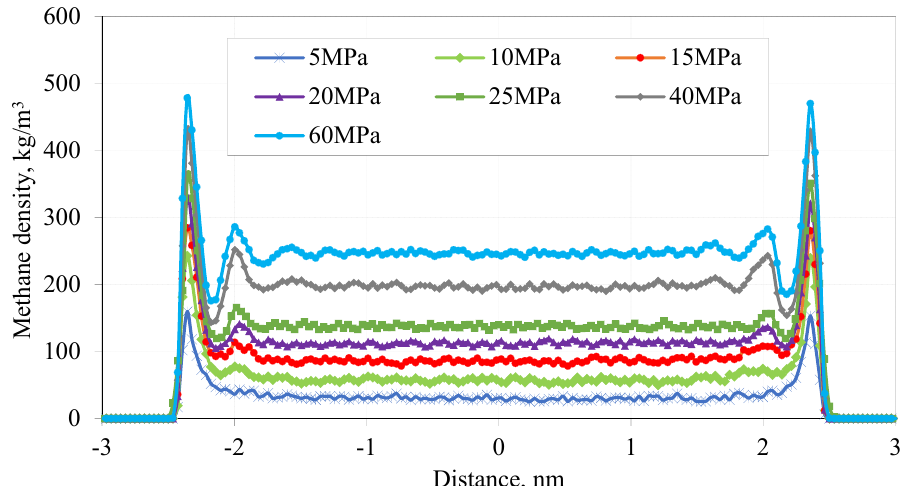
Figure 12. Methane density distribution curve in illite slit-shaped pore space (including pore walls).